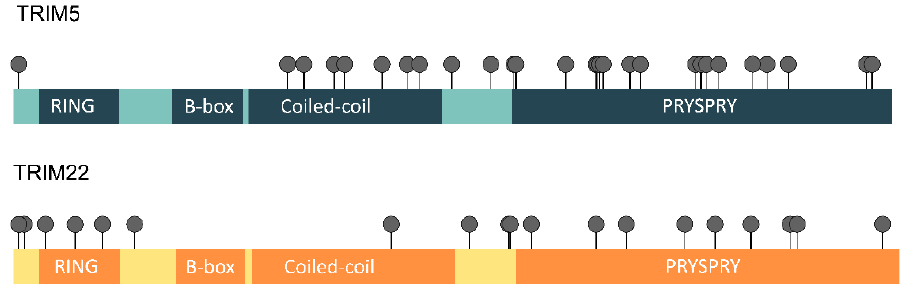
Figure 5. Amino acids under positive selection in TRIM5 and TRIM22. This diagram illustrates the position of the amino acids determined to be under positive selection in TRIM5 and TRIM22 by at least three of the five models of selection implemented (see Methods). In total, 31 TRIM5 positively-selected residues were detected, of which 7 were localized in the coiled-coil domain, 21 in the PRYSPRY domain, and 3 outside any domains. For TRIM22, of the 19 selected positions, 3 were found inside the RING domain, 1 in the coiled-coil domain, and 9 in the PRYSPRY domain. The remaining 6 residues are not placed within the bounds of any TRIM22